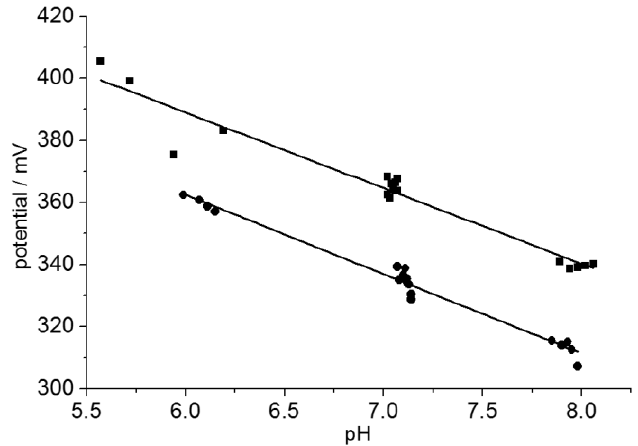
Figure 9. Cyclic potential measurements with a 20-nm (squares) and a 60 nm pH sensor (circles) between pH 6 and pH 8. The potentials were detected after 5 min before solution exchange and plotted over the reference pH. Sensitivities of −24.8 ± 0.8 mV (20 nm) and −25.6 ± 0.9 mV (60 nm) per pH step were obtained from linear